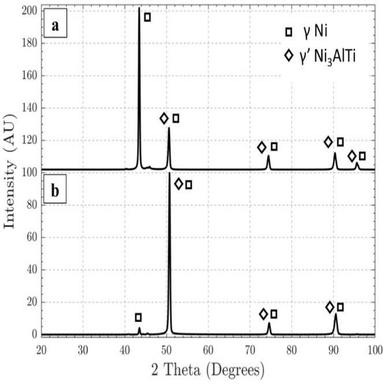
Phases of the conventional (a) and DED fabricated (b) IN718.